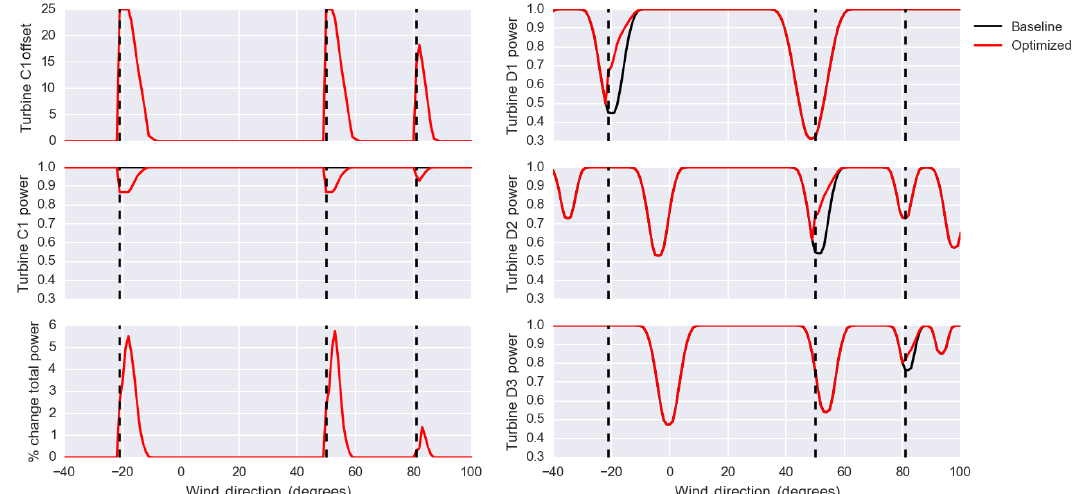
Figure 3. FLORIS optimal yaw misalignment results. The dashed vertical line indicates the direction in which the downstream turbine is fully waked by turbine C1. See Fig. 2 for details on the precise wind directions. Specifically, the first dashed line (from left to right) refers to the direction of turbine C1 fully waking downstream turbine D1. The second dashed line refers to the direction of turbine C1 fully waking downstream turbine D2. Finally, the third dashed line refers to the direction of turbine C1 fully waking downstream turbine D3. Wakes from turbines other than C1 are also evident from the dashed lines. Note that for the power subplots, the power is given normalized to the power of the turbine in un-yawed and un-waked conditions